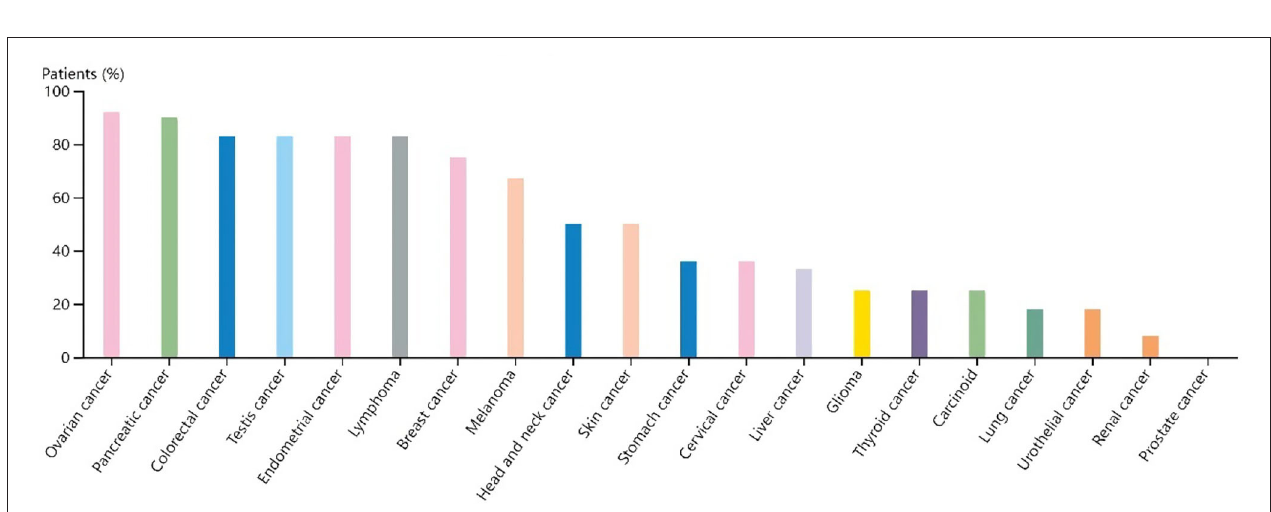
FIGURE 8 | THBS1 showed moderate to strong membranous staining in malignant tumor cells, with occasional cytoplasmic staining. SERPINE1 was negatively expressed in all tumor tissues via The Human Protein Atlas.